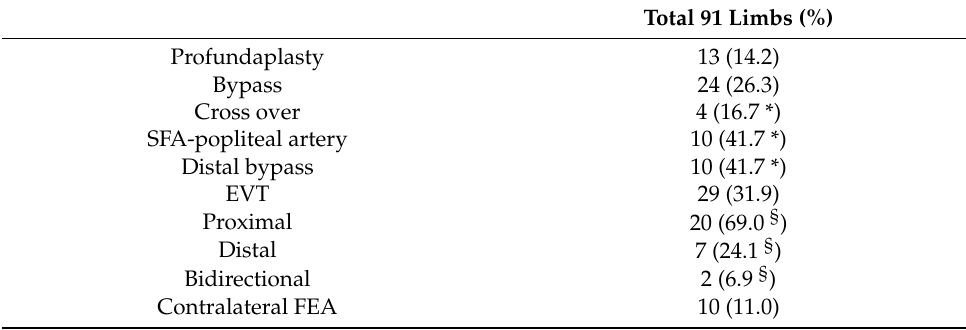
Table 3. Adjunctive vascular procedures of femoral endarterectomy.